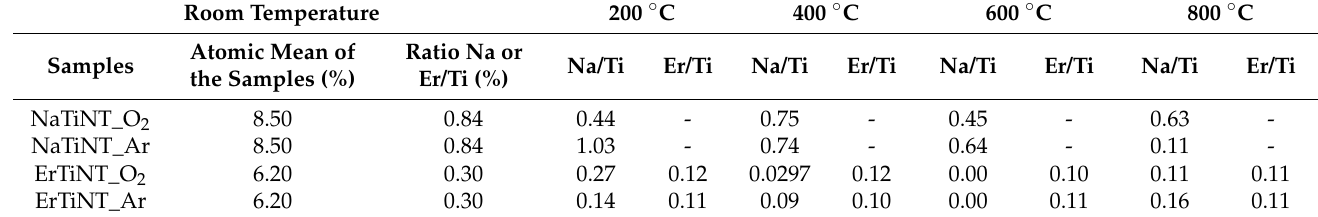
Table 1. Samples of NaTiNT and ErTiNT heat treated in air (O 2 ) and argon atmospheres presenting the atomic ratios Na/Ti and Er/Ti obtained by EDS.